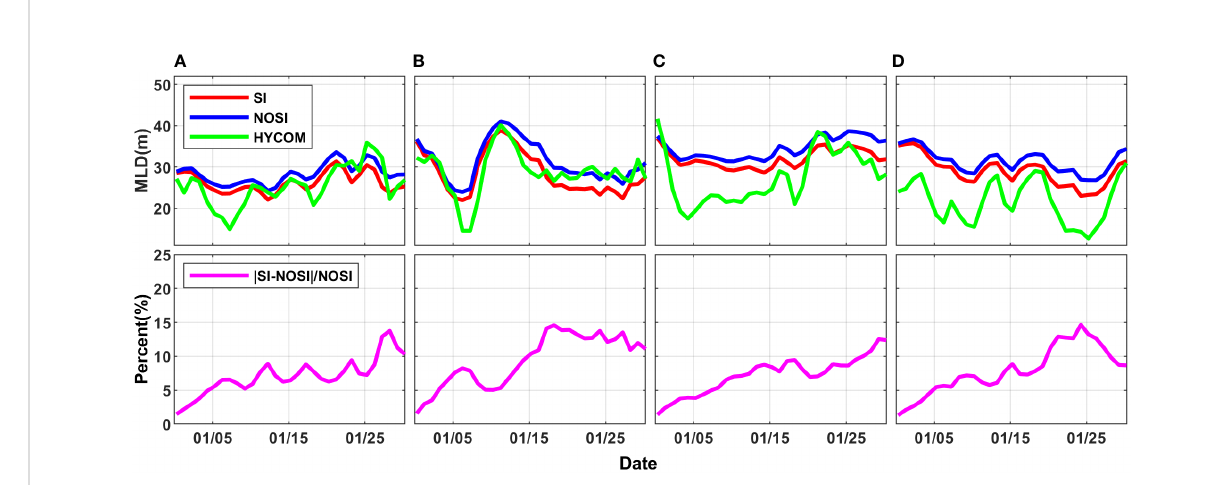
FIGURE 11 The time series of the domain-averaged MLD from the simulations (blue and red line for R1_NOSI and R1_SI, respectively) and the proportion of the MLD difference (magenta line) to the one from R1_NOSI in January (A) 2017, (B) 2018, (C) 2019, (D) 2020. The concurrent MLD from the reanalysis is shown as the green